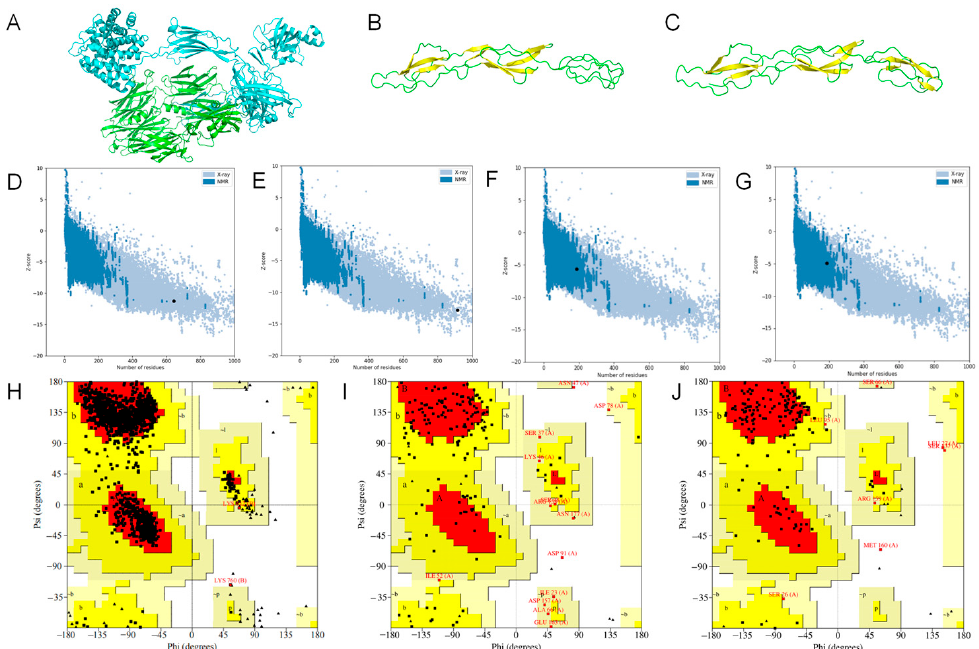
Figure 1. Homology modeling and assessment of C3b and CR1-like fragments. ( A ) C3b model constructed by AlphaFold-Multimer. The green chain is the C3b β chain, and the cyan chain is the C3b α chain. ( B ) CR1-like SCR 12–14 model constructed by I-TASSER. The yellow region is the β -fold, and the green region is the loop region. ( C ) CR1-like SCR 19–21 model constructed by I-TASSER. The yellow region is the β -fold, and the green region is the loop region. ( D–G ) Z scores of C3b β chain, C3b α chain, CR1-like SCR 12–14, and CR1-like SCR 19–21. ( H–J ) Ramachandran plots of C3b, CR1-like SCR 12–14 and, CR1-like SCR 19–21. Glycine residues are displayed as triangles while other residues are displayed as squares. Residues in the most favored regions (A, B, L) are those with phi and psi angles that are most energetically favorable. Residues in additional allowed regions (a, b, l, p) are less energetically favorable, but still allowed. Residues in generously allowed regions (~a, ~b, ~l, ~p) are the least energetically favorable but still